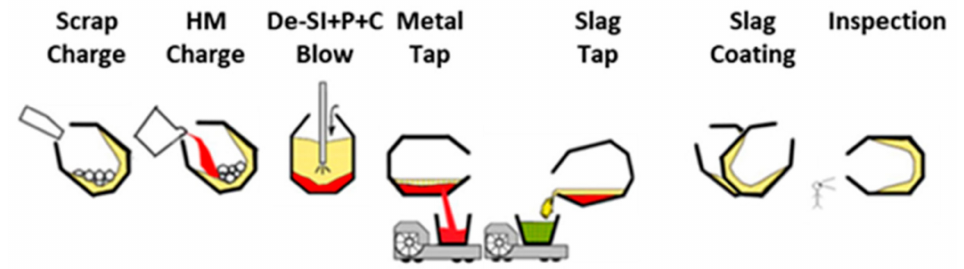
Figure 10. Straight-blow practice (blow-stir